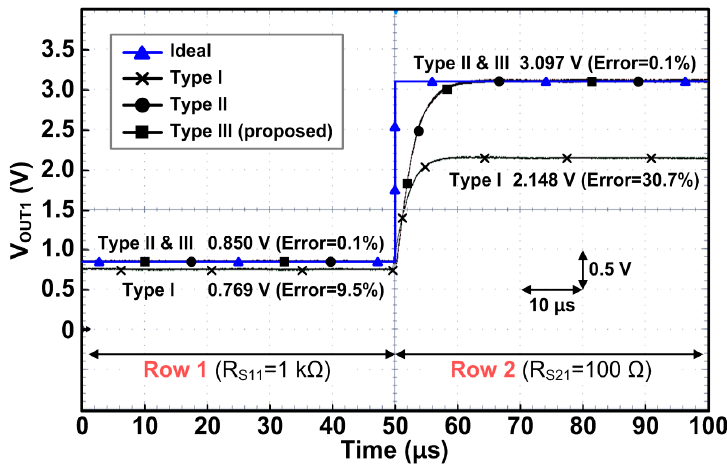
Figure 14. Measured waveforms of row drivers Type I, II, and the proposed Type III.